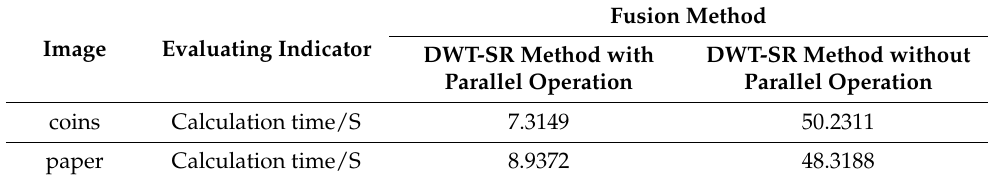
Table 1. Comparison of computing speed of improved algorithm with or without GPU parallel